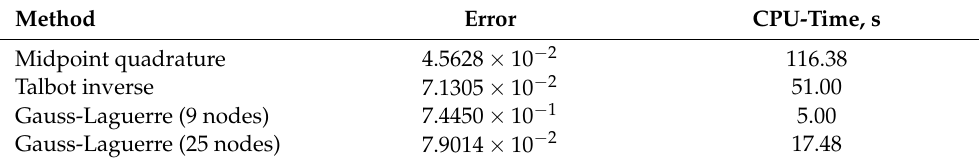
Table 4. A comparison of various methods of numerical integration for Example